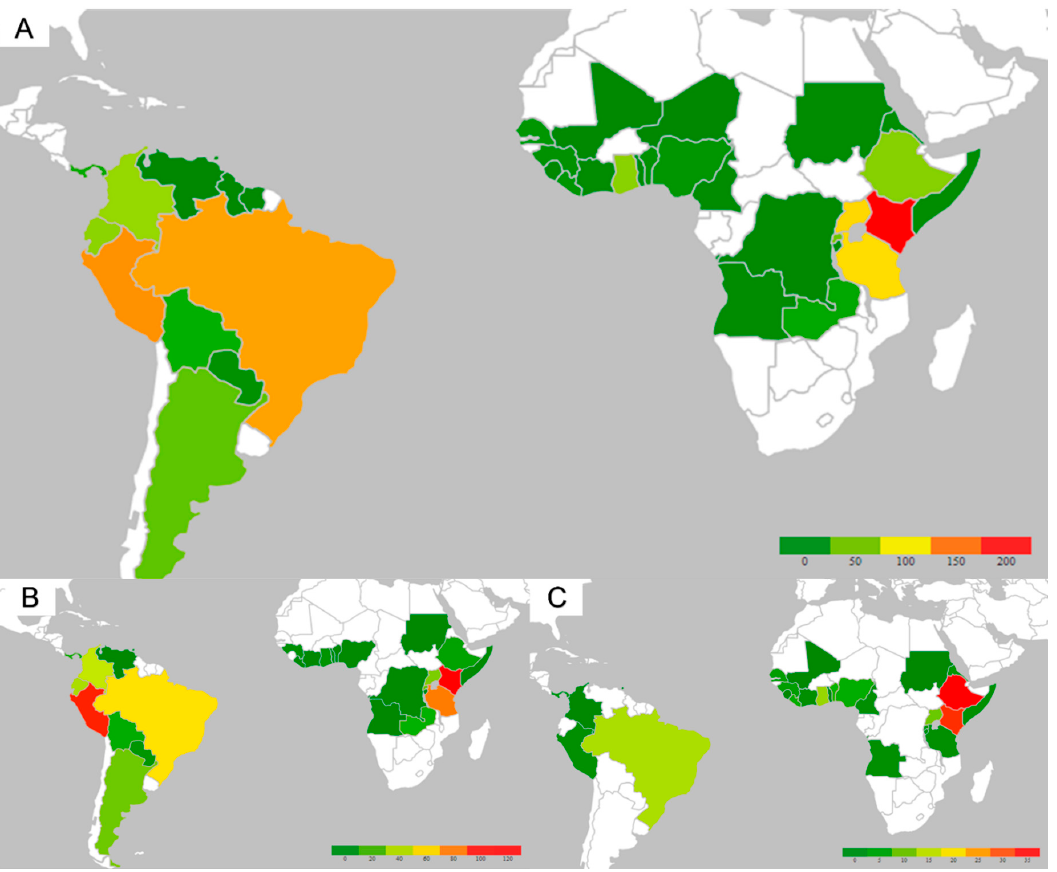
Figure 1. Heat map of destinations among patients receiving the yellow fever (YF) vaccine. ( A ). Heat map of countries of destination for the total cohort. ( B ). Heat map for travelers going for leisure. ( C ). Heat map for travelers going to visit friends and family. The density of patients is represented by color bars.